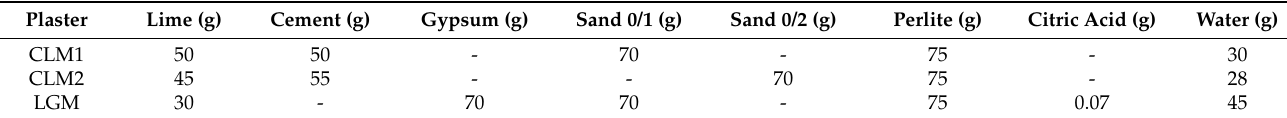
Table 1. Composition of the investigated